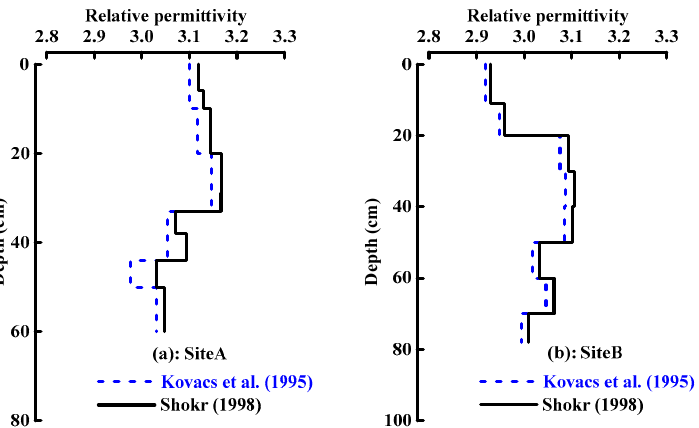
Figure 9. Dielectric permittivities of river ice at Site A ( a ) and Site B ( b ) calculated using the equations presented by Kovacs et al. [40] and Shokr [41].